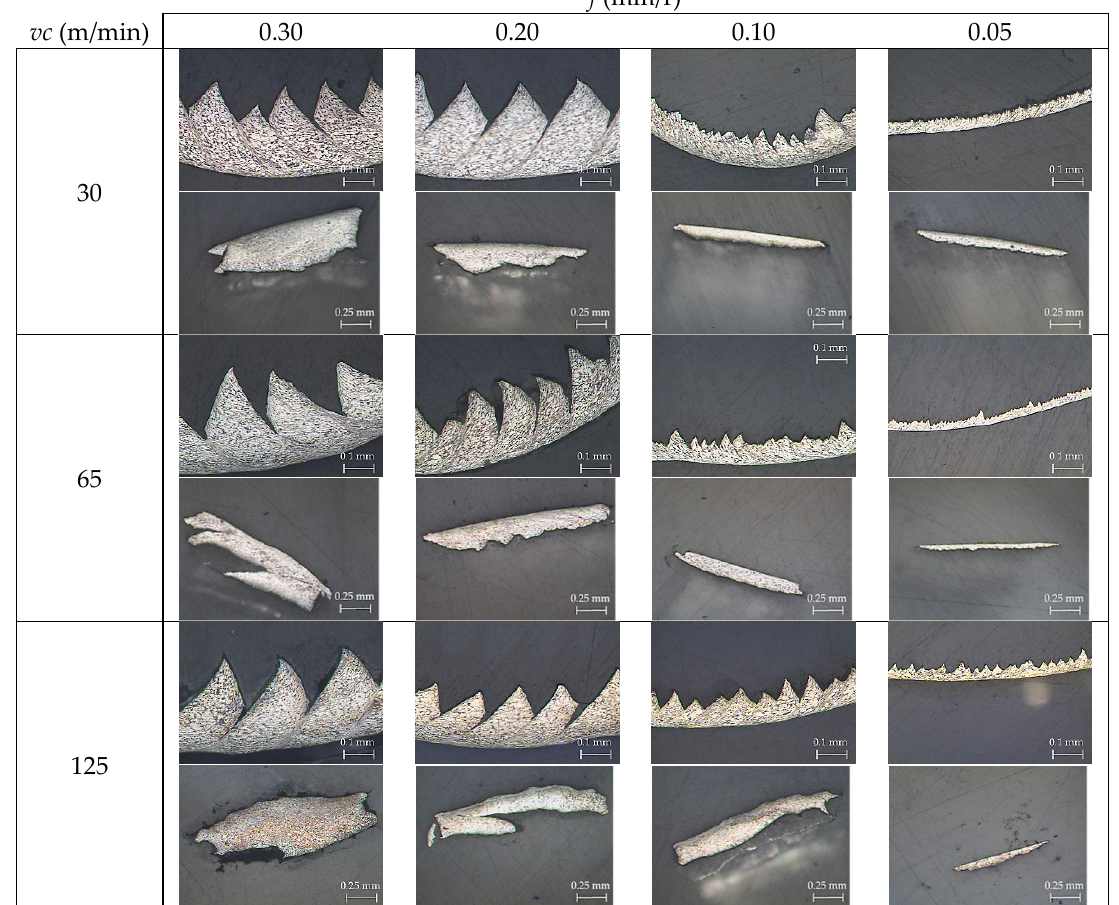
Figure 6. SOM images of the longitudinal (20×, 0.1 mm of each segment) and transverse (10×, 0.25 mm of each segment) chip sections.